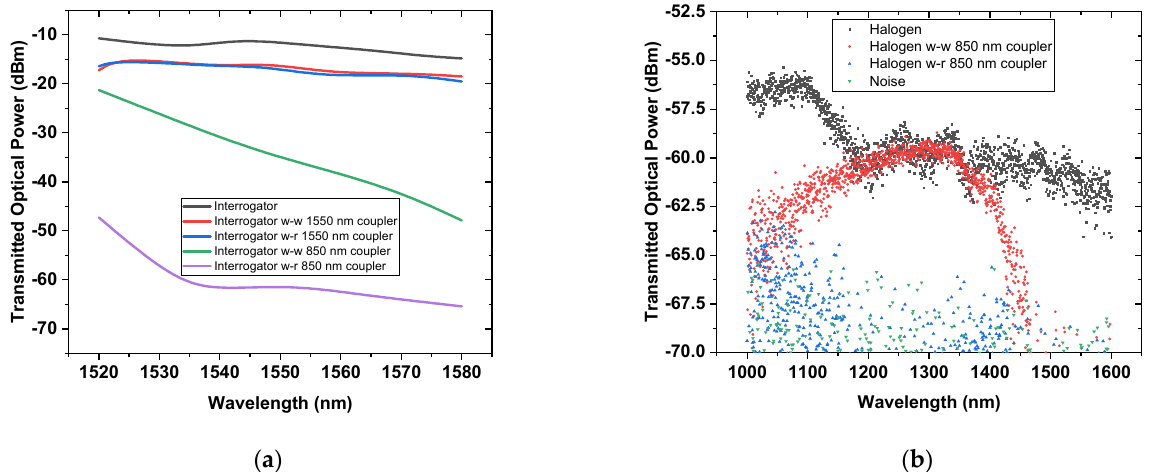
Figure 5. Transmission optical power via optical fiber coupler when the interrogator ( a ) or the halogen light source ( b ) is used.